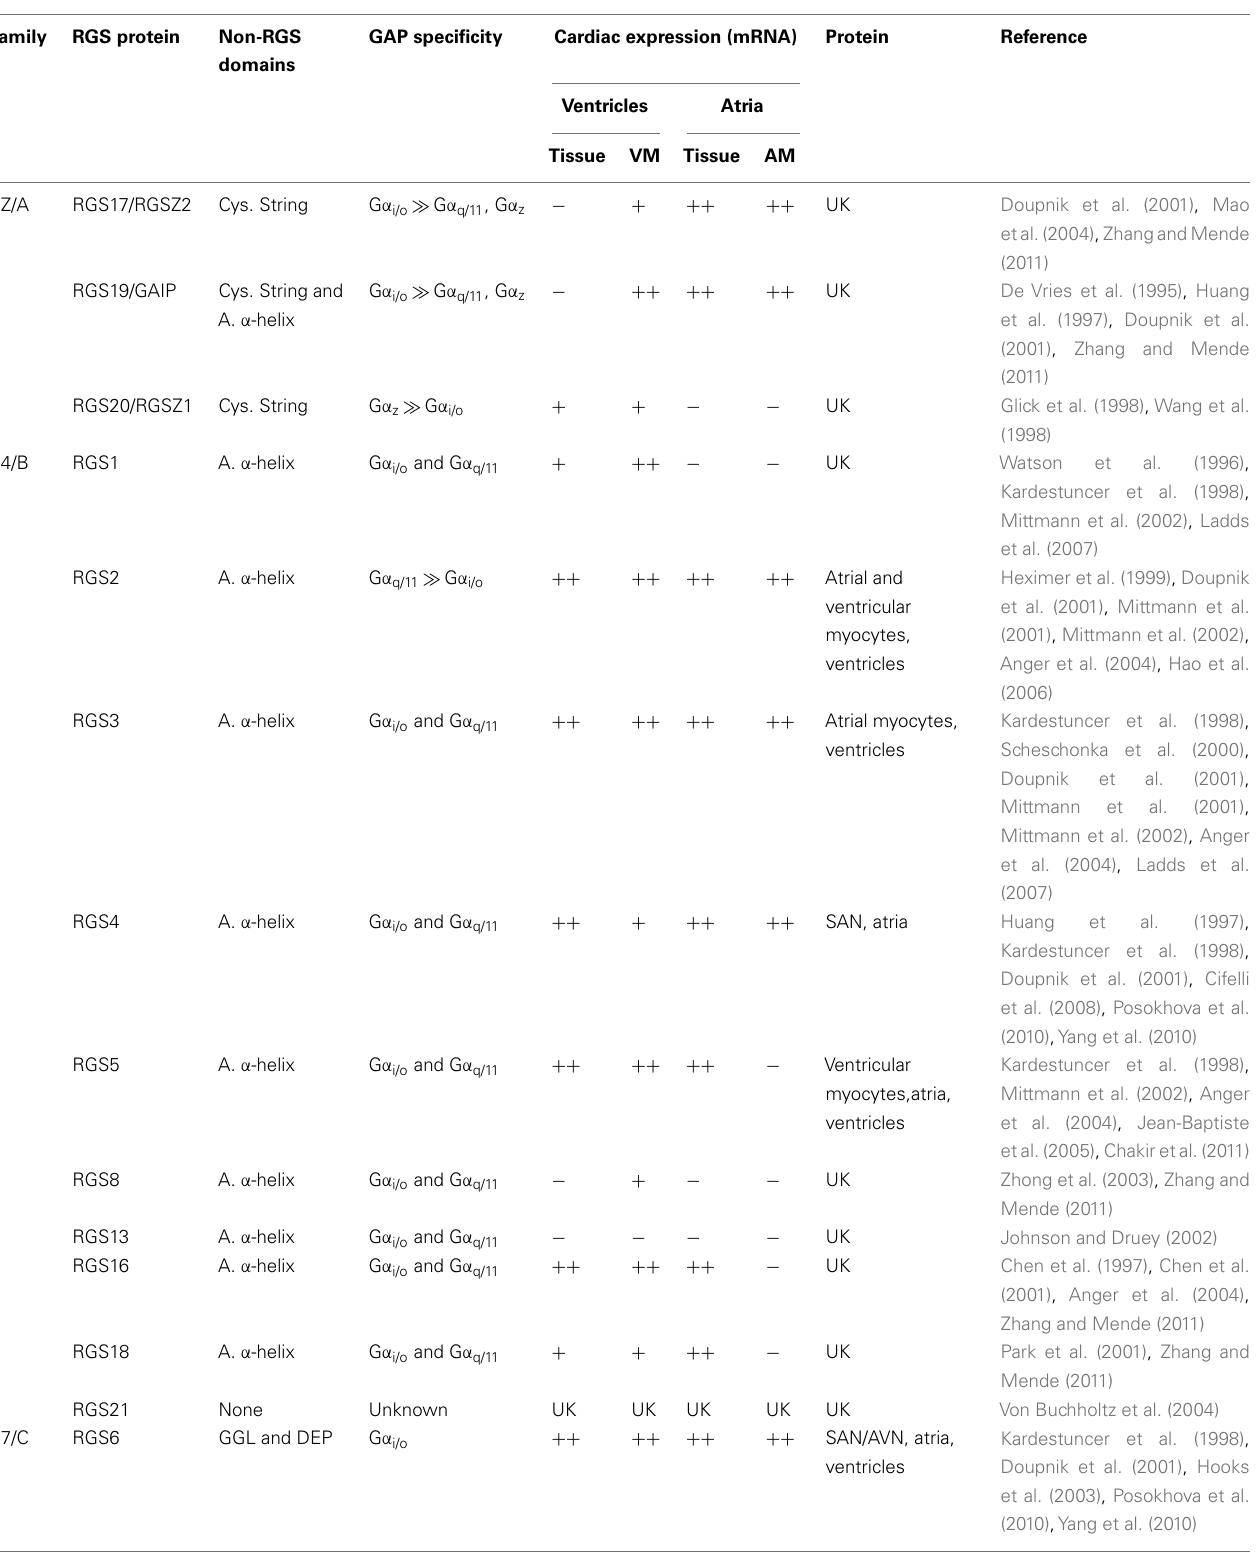
Table 1 | Canonical RGS protein structure, GAP activity, and expression in cardiac tissue.